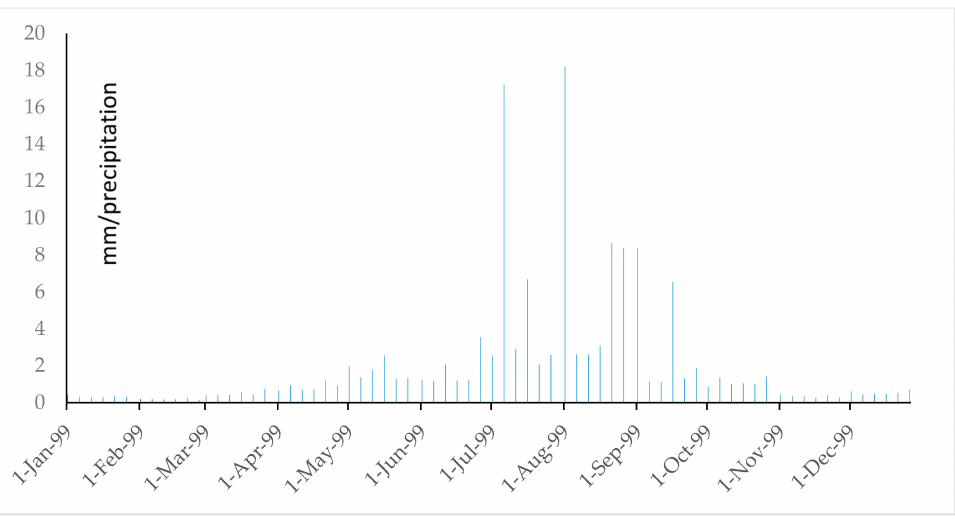
Figure A27. Precipitation of Denko County in